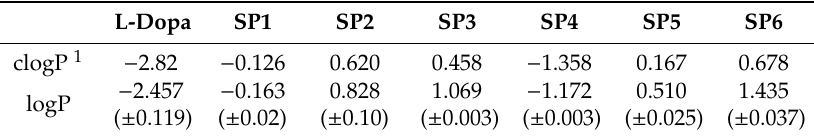
Table 1. Physico-chemical properties of SP1-6 .